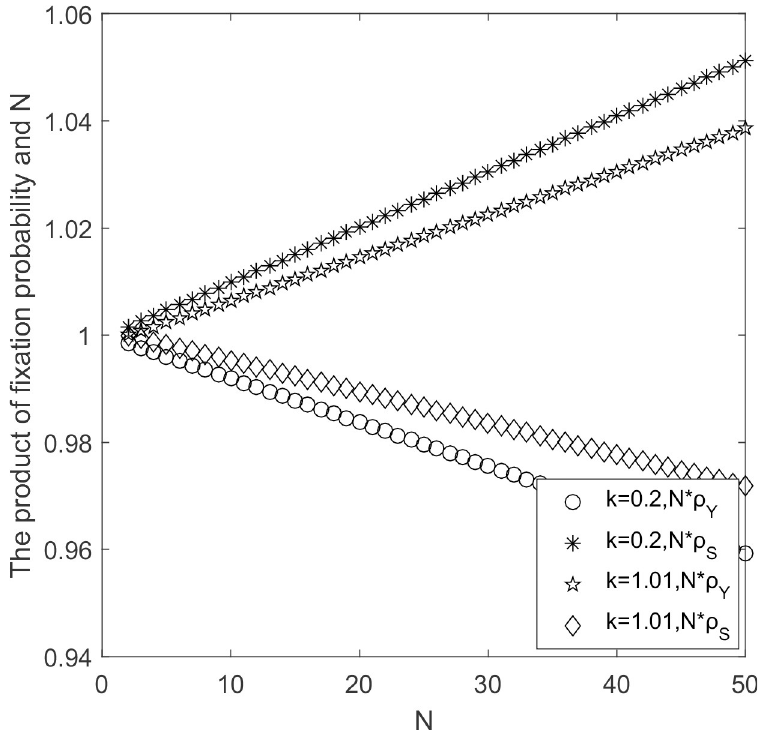
Fig 7. N � ρ Y /N � ρ S ~ k change